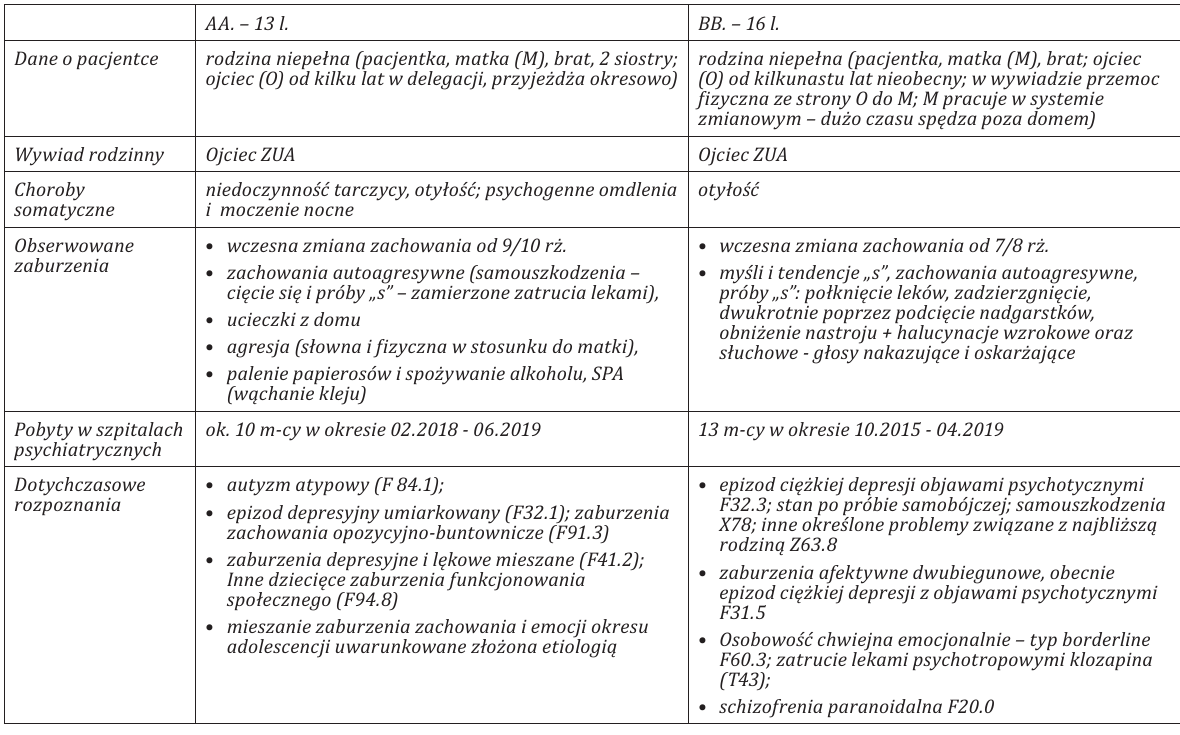
Tabela 1. Zestawianie danych dotyczących obu pacjentek, z uwzględnieniem czasu trwania hospitalizacji i stawianych w przeszłości rozpoznań.